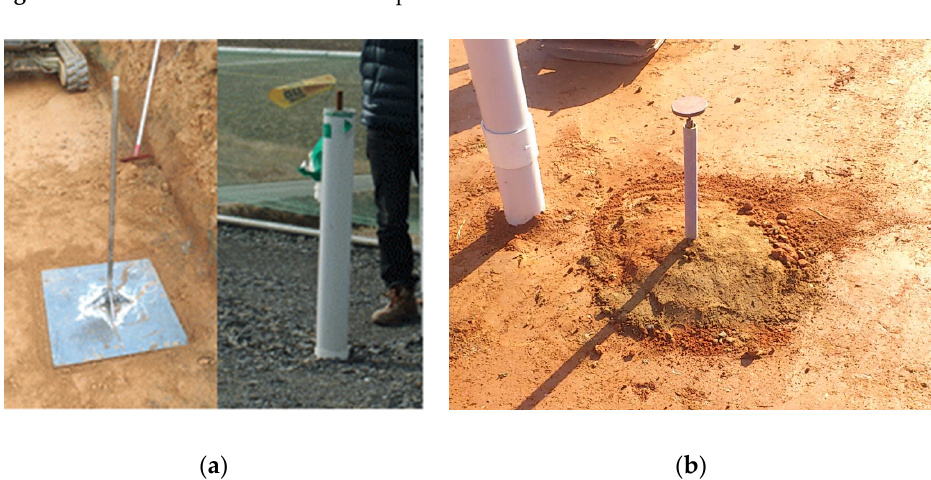
Figure 9. Settlement measuring device: ( a ) Ground settlement rod; ( b ) Surface settlement rod.